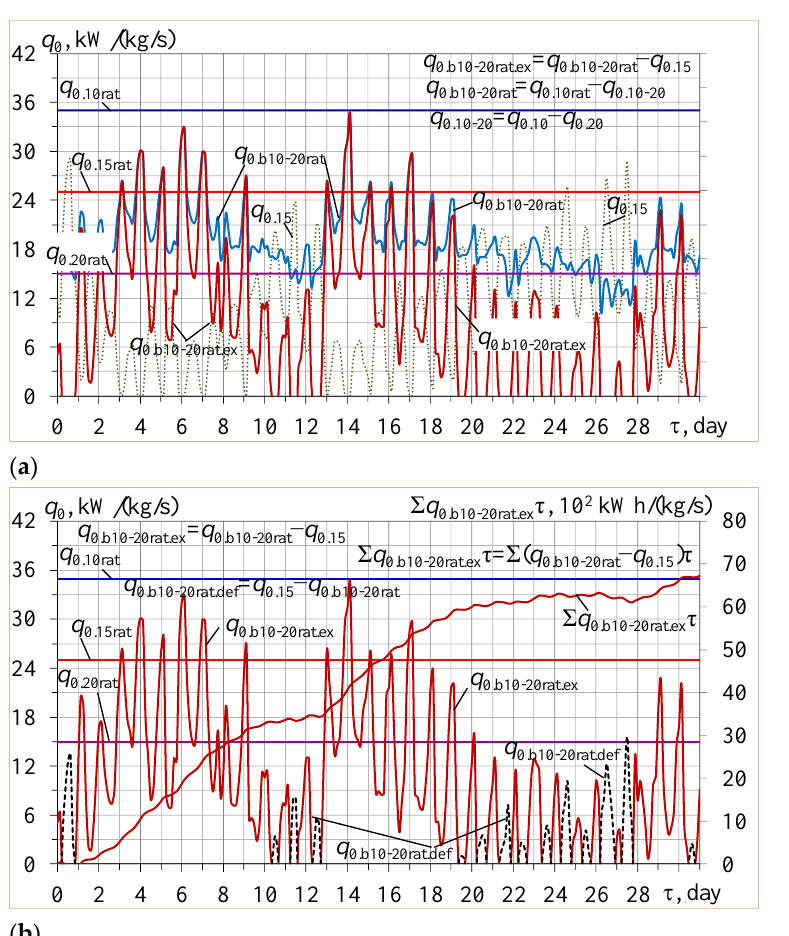
Figure 3. Rational values of refrigeration capacities q 0.10rat , q 0.15rat and q 0.20rat for conditioning outdoor air to 10 °C, 15 °C and 20 °C accordingly; actual refrigeration capacities q 0.15 needed for preconditioning air to 15 °C, and available booster refrigeration capacity q 0.b10-20rat for preconditioning air and booster refrigeration capacity exceedance q 0.b10-20rat.ex over q 0.15 ( a ), and its deficit q 0.b10-20rat.def , summarized monthly refrigeration energy exceedance ∑ q 0.b10-20rat.ex over q 0.15 ( b ): q 0.b10-20rat = q 0.10rat – q 0.10-20 , q 0.b10-20rat.ex = q 0.b10-20rat – q 0.15 , q 0.b10-20rat.def = q 0.15 – q 0.b10-20rat , ∑ q 0.b10-20rat.ex = ∑ (q 0.b10-20rat – q 0.15 ) τ .